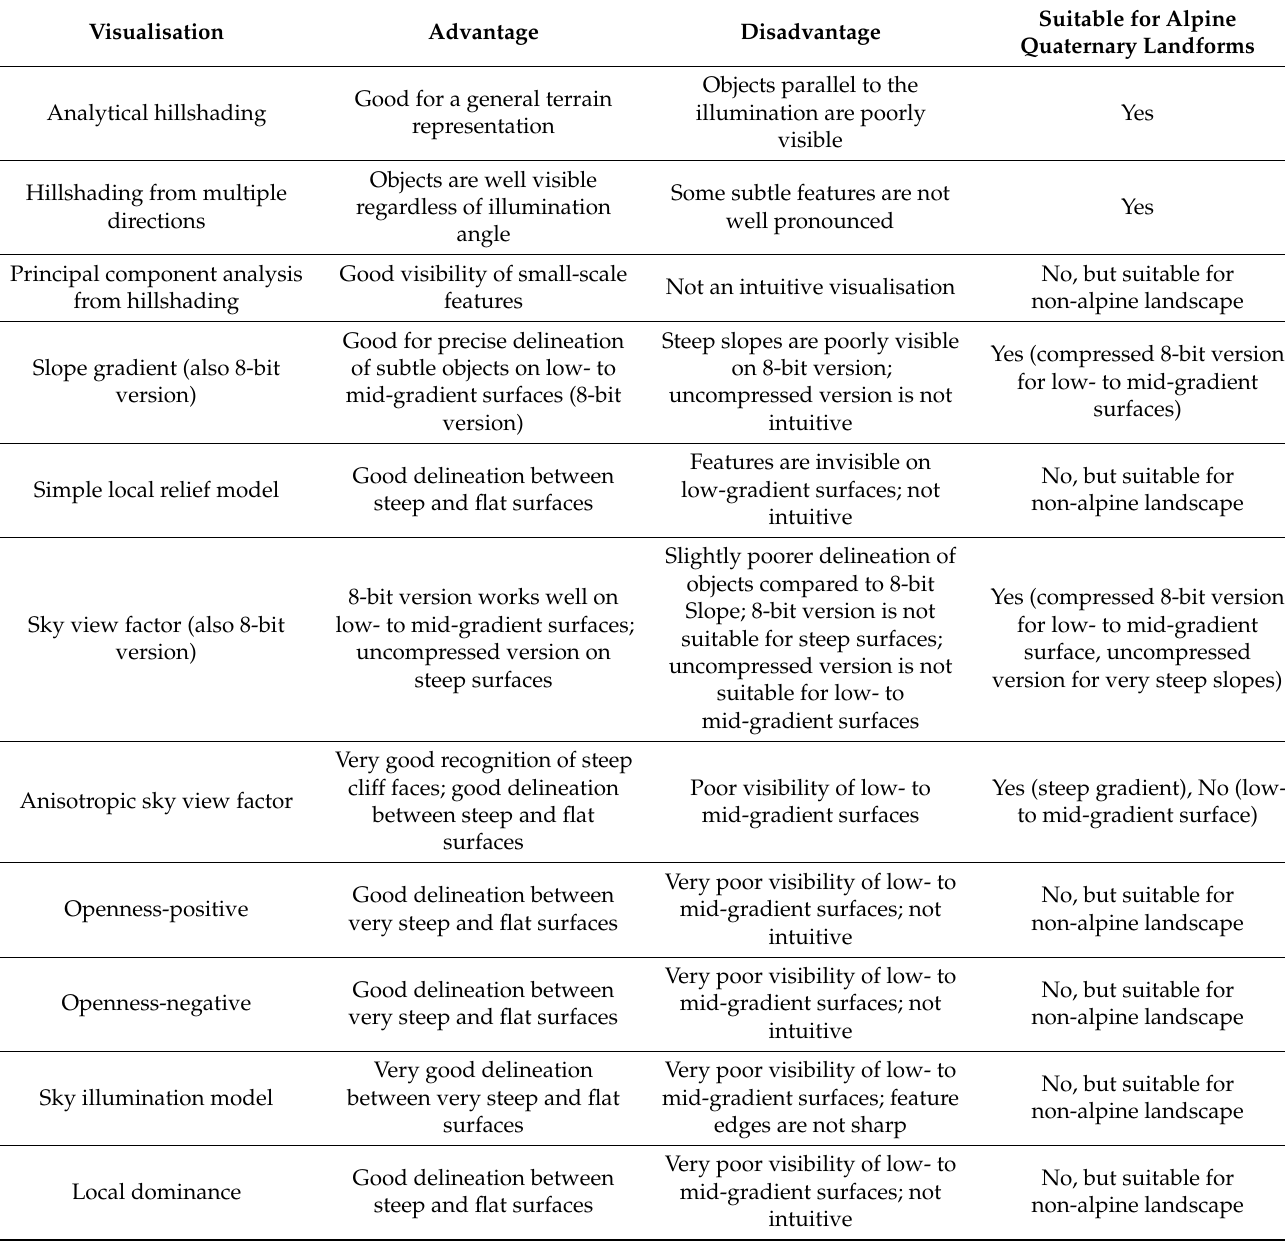
Table 3. Summary of advantages and disadvantages of each visualisation technique for visualising Quaternary landform features in alpine